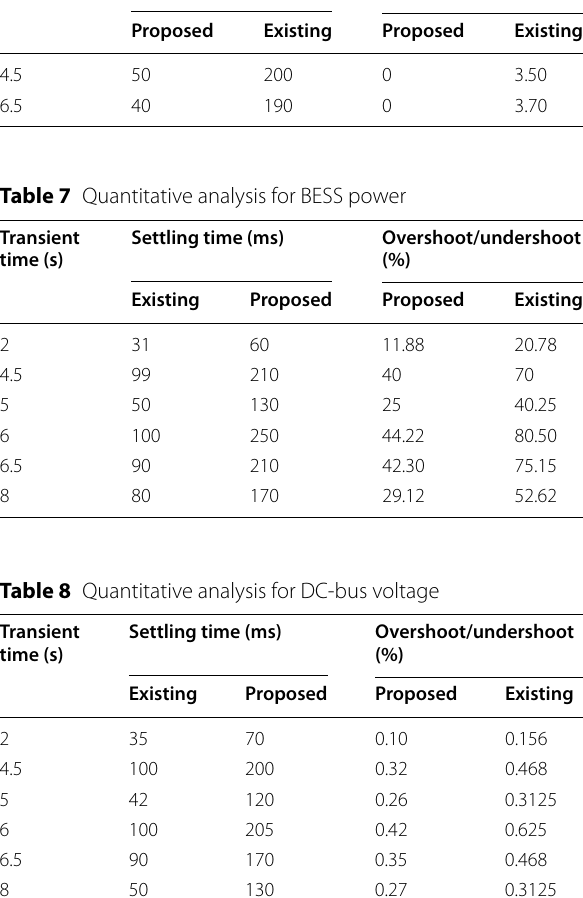
Table 6 Quantitative analysis for AC load power Transient Settling time (ms) time (s)